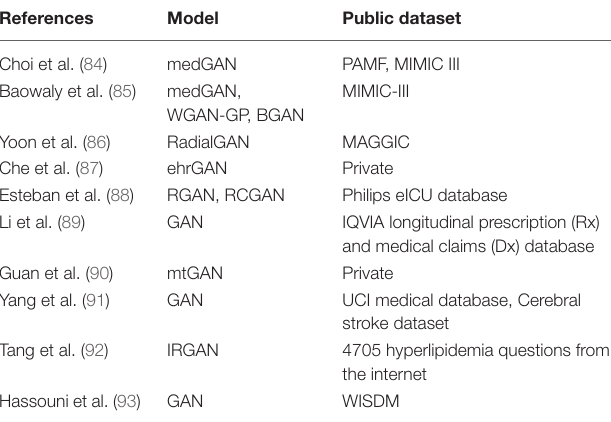
TABLE 3 | Literatures for the application of GAN in medical informatics.